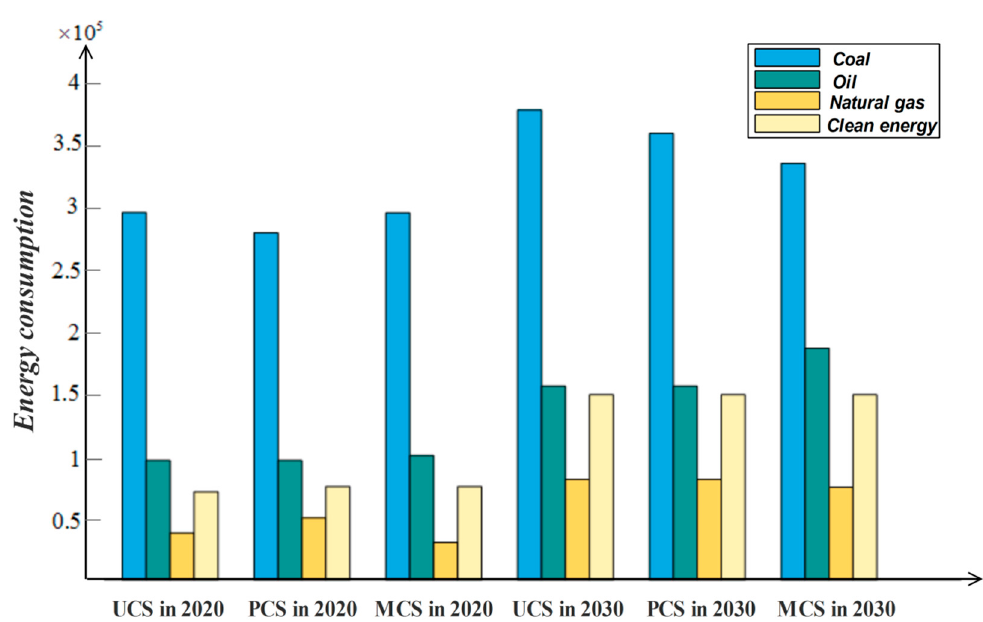
Figure 3. Energy consumption under different scenarios in China in 2020 and 2030.